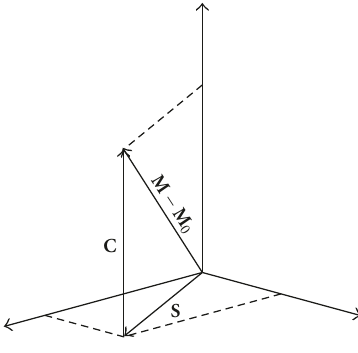
Figure 1: Schematic illustration of the NAP technique in a 3-dimensional supervector space. The speaker- and channel- dependent supervector M can be written as the sum of two supervectors, one of which ( S ) lies in the speaker space and the other ( C ) lies in the channel